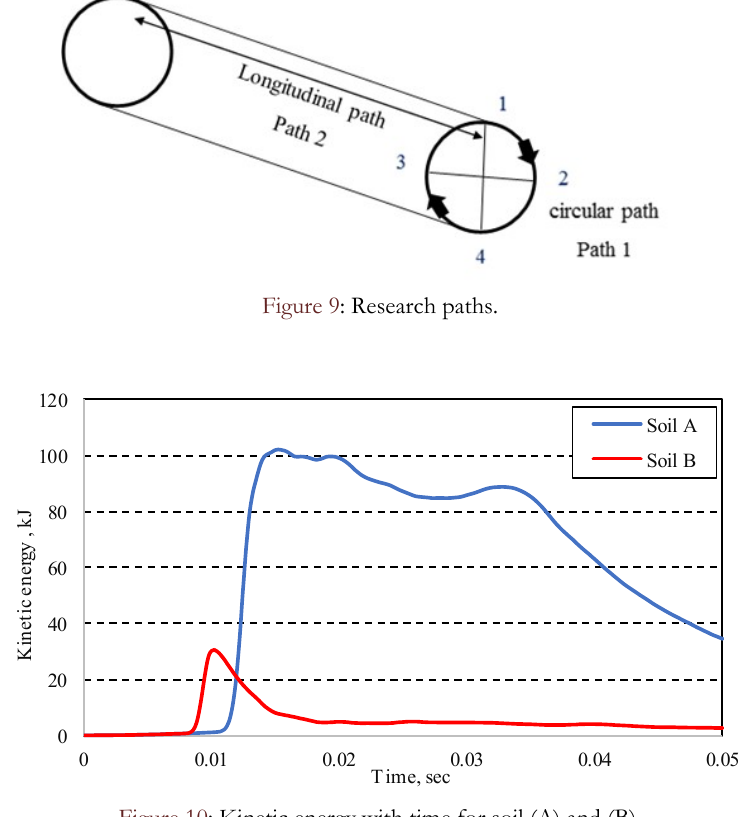
Figure 10: Kinetic energy with time for soil (A) and (B).